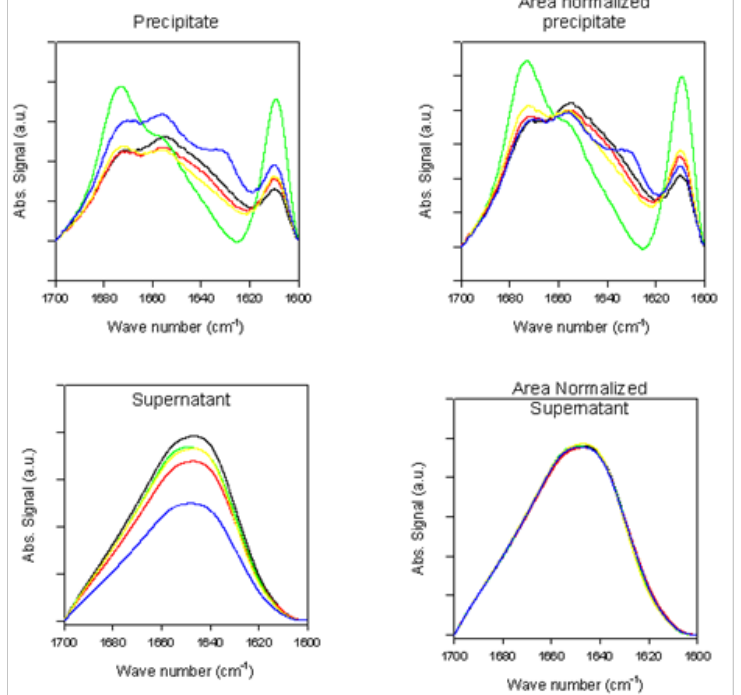
Figure 3. Superimposed ATR-FTIR spectra of precipitate samples (top panels) and supernatant samples (bottom panels) taken at time of rotenone addition (black, red green, yellow and blue curves correspond to measurements taken at 0, 0.25, 0.5, 1, and 3 h,